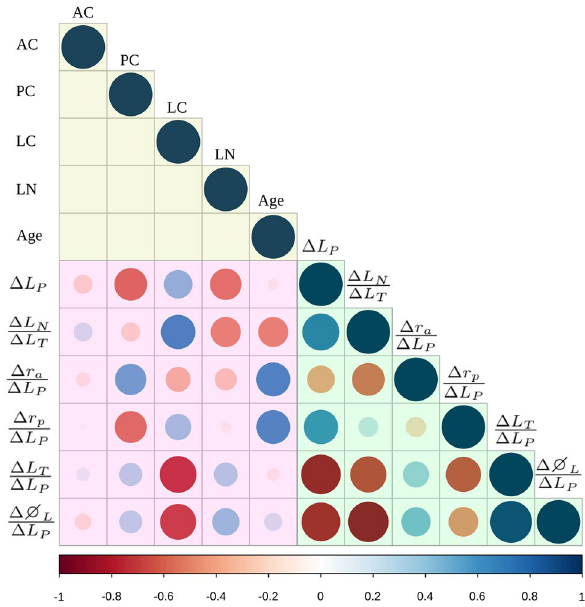
Figure 6. Pearson correlation matrix (full-level factorial design, 2 · 5 4 = 1250 ). Factors: stiffness of the anterior capsule (AC), posterior capsule (PC), lens cortex (LC) and lens nucleus (LN), and the lens geometry depending on age (Age). Level − 1 corresponds to 17 y/o and level 1 to 29 y/o). Biometric lens measurements: (cid:31) L P , (cid:31) L N (cid:31) L (cid:31) r p (cid:31) L T (cid:31) ∅ L (cid:31) L P , (cid:31) L P , (cid:31) L P , and (cid:31) L P . The color of each circle depicts whether the linear correlation is direct (positive) or inverse (negative) (blueish palette, direct; reddish palette, inverse). The larger the circle diameter, the higher the